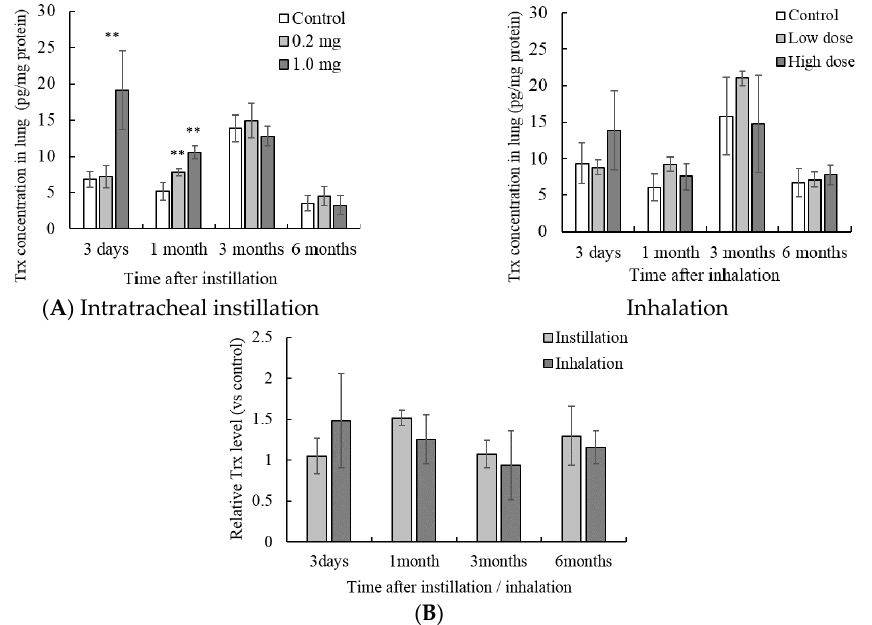
Figure 4. Influence of NiO nanoparticle exposure on the concentration of thioredoxin (Trx) in lung tissue. ( A ) The concentration of Trx in the lung after intratracheal instillation and inhalation. The Trx concentration was measured using ELISA. Values are mean ± SE ( n = 5). Significant differences versus control group are indicated in the figure (ANOVA, Dunnet). ** p < 0.01; ( B ) Comparison of 0.2 mg intratracheal instillation and high dose inhalation. The data show the relative level of the Trx protein concentration against each control group.